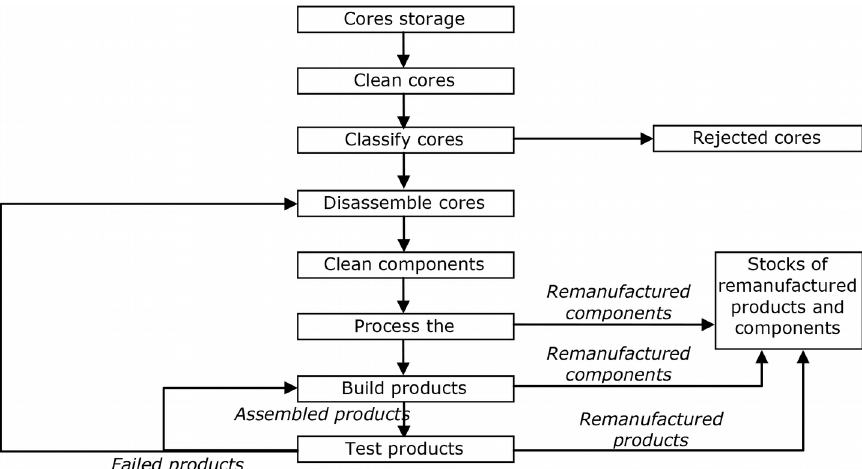
Figure 4. Process of remanufacturing (Ijomah et al.,